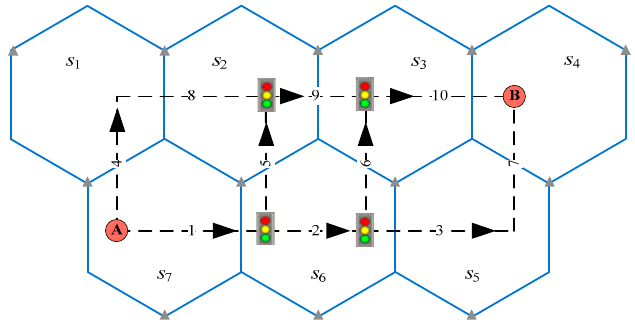
Figure 4. Small-sized network (for simplicity, the Thiessen polygon is not considered herein). Table 1. The travel routes and the ID paths.